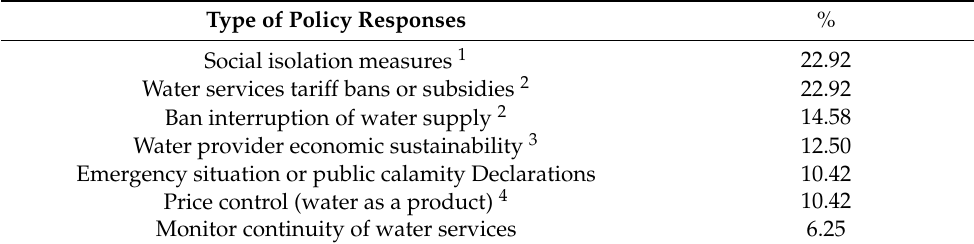
Table 4. Types of coronavirus policy responses across the 48 measures